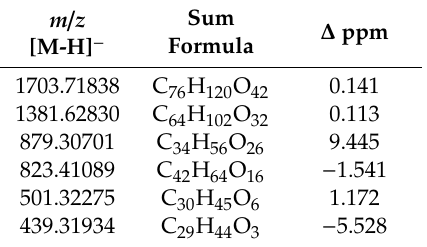
Table 2. Most probable sum formula and ppm deviation for the fragment ions of m / z 1703.71734.